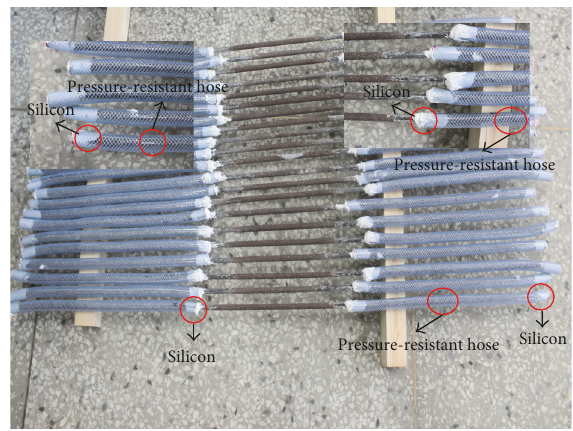
Figure 4: Protection of specimens anchoring